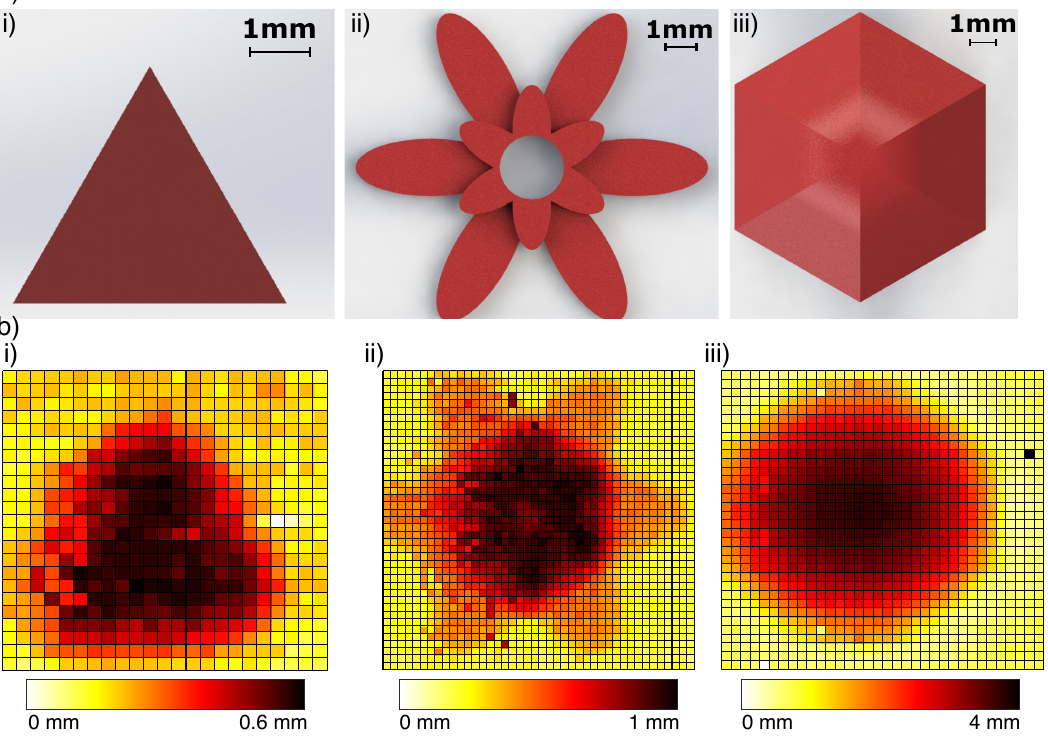
Figure 10. 3D printed PLA models were palpated and reconstructed using a simple signal thresh- old. ( a ) CAD models 3D printed for the stimulus: (i) 0.6mm high triangle, (ii) flower model with 2-step height of 0.5 and 1 mm, (iii) a hexagonal dome with steep edges reaching 4mm height. ( b ) Tactile reconstruction of the shapes after a single pass, where each cell on the grid represents a 0.5 mm × 0.5 mm palpated region and the colourbar shows the elevation from the test surface: (i) triangle, (ii) flower, (iii)